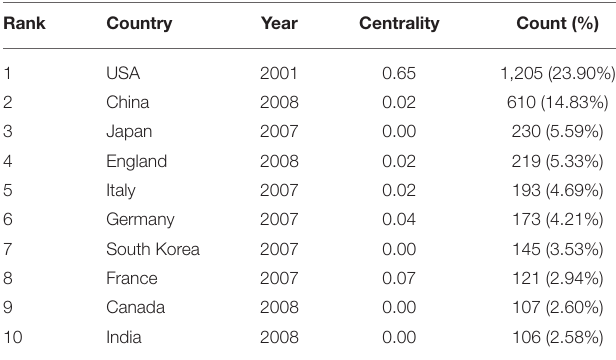
TABLE 1 | Top 10 countries based on the total number of publications for the period